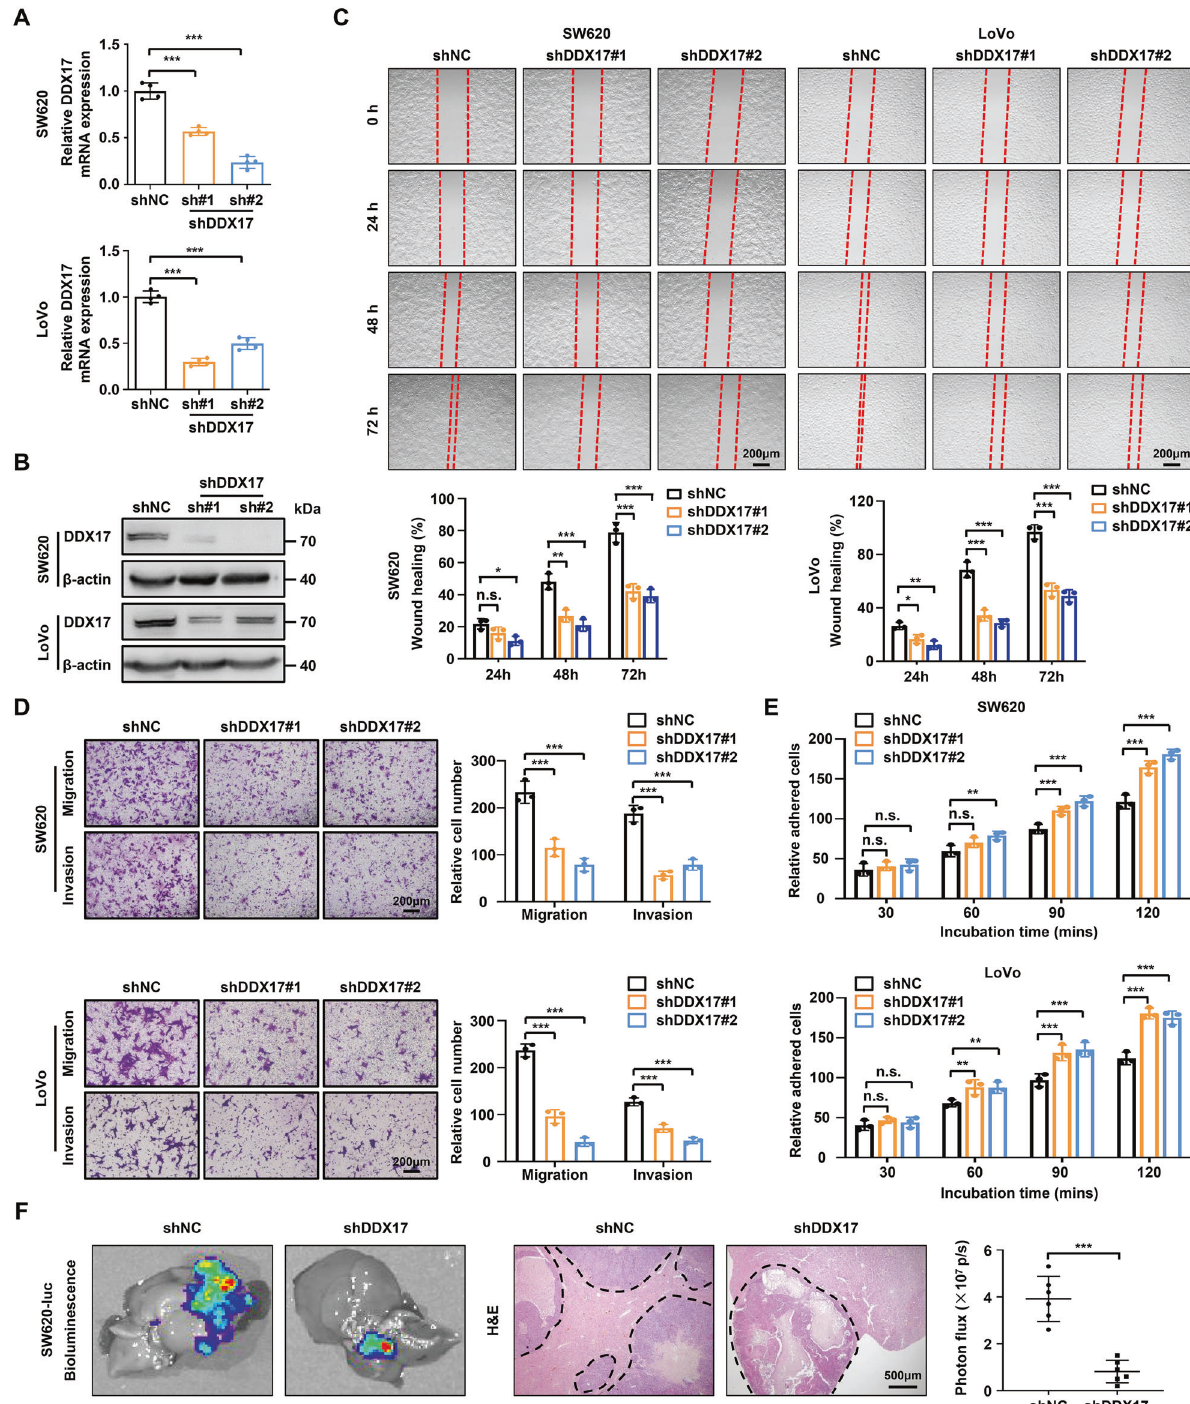
Fig. 2 DDX17 silencing suppresses the migration and invasion of CRC cells in vitro and in vivo. A , B RT ‒ qPCR ( A ) and western blot ( B ) analysis veri fi ed the downregulation of DDX17 mediated by two speci fi c shRNAs targeting DDX17 in SW620 and LoVo cells. C Microscopic observations were recorded at 0, 24, 48, and 72 h after scratching the surface of a con fl uent layer of the indicated SW620 and LoVo cells. D The effects of DDX17 on cell migration and invasion were examined by transwell assays in SW620 and LoVo cells. E The numbers of adhesive SW620 and LoVo cells on the Matrigel were recorded after 30, 60, 90, and 120 min. F DDX17-de fi cient and control SW620 cells were injected into the spleens of nude mice. Representative bioluminescent and H&E staining images of the isolated liver tissues were obtained, and the light emissions were quanti fi ed. n.s. no signi fi cance, ** P < 0.01, *** P < 0.001.